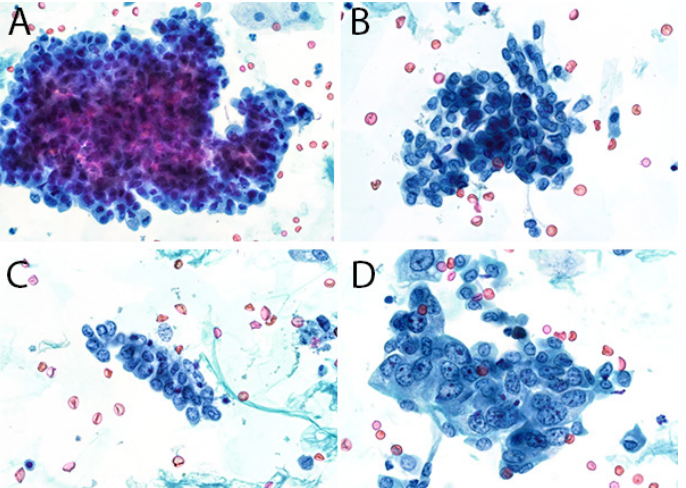
Figure 3. Fragments from a specimen containing high-grade urothelial carcinoma. ( A ), At low magnification, the nuclei appear dark and disorganized within the fragment. Assessment at higher magnification is required. ( B ), The nuclei in this fragment have high N/C ratios and nuclear contour irregularities. However, the nuclei are around the same size, and the chromatin pattern is bland. It contains sufficient atypia to consider the Atypical Urothelial Cells category. ( C ), The cells in this fragment have high N/C ratios and contain irregularly distributed chromatin clumps. There is a small but noticeable variation in nuclear size (2:1). The chromatin is paradoxically hypochromatic. ( D ), This fragment contains cells with overtly malignant features. The nuclear contours are markedly irregular, and there is significant variation in nuclear size (4:1). The chromatin forms randomly distributed clumps.